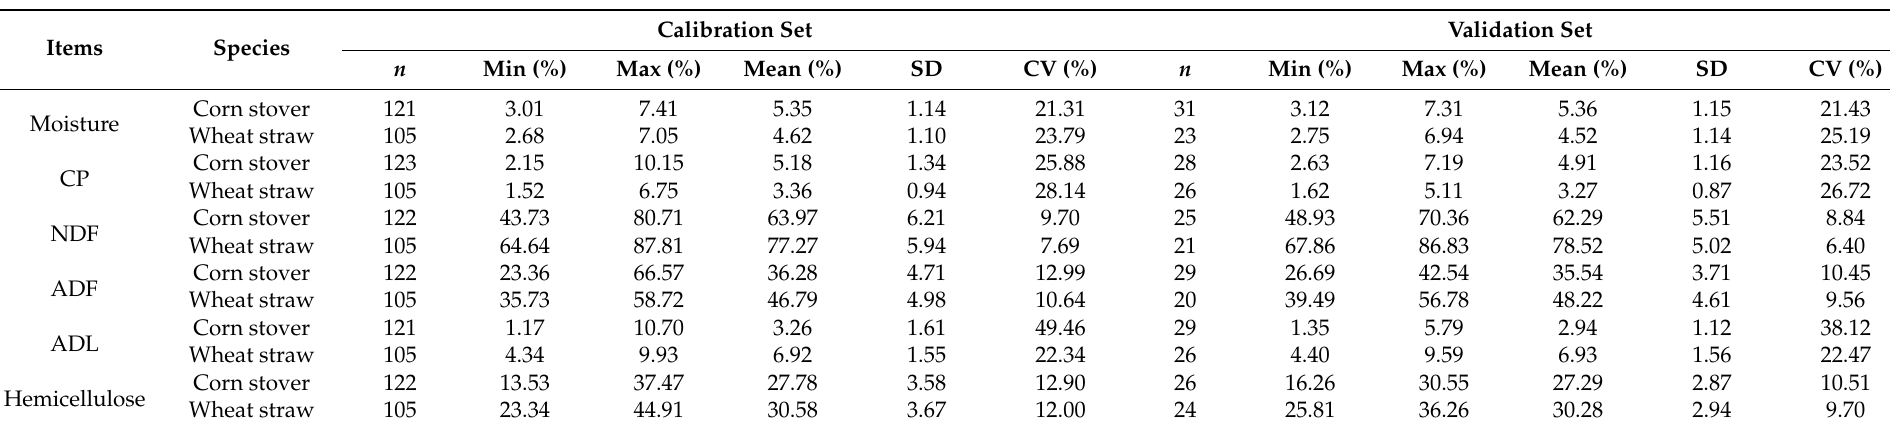
Table 2. Descriptive statistics for the six constituents of straw used for the development of NIRS calibration and validation models (wet-chemical analysis, DM basis). Items